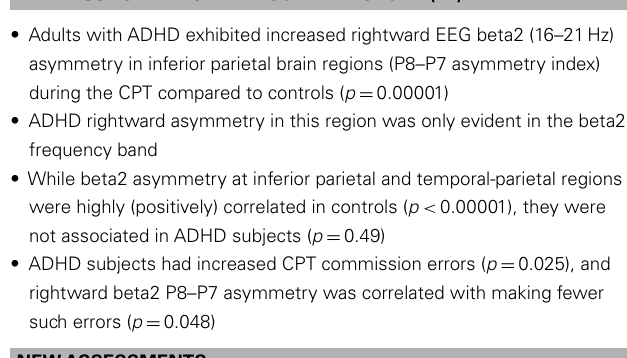
Table 1 | Summary of study goals